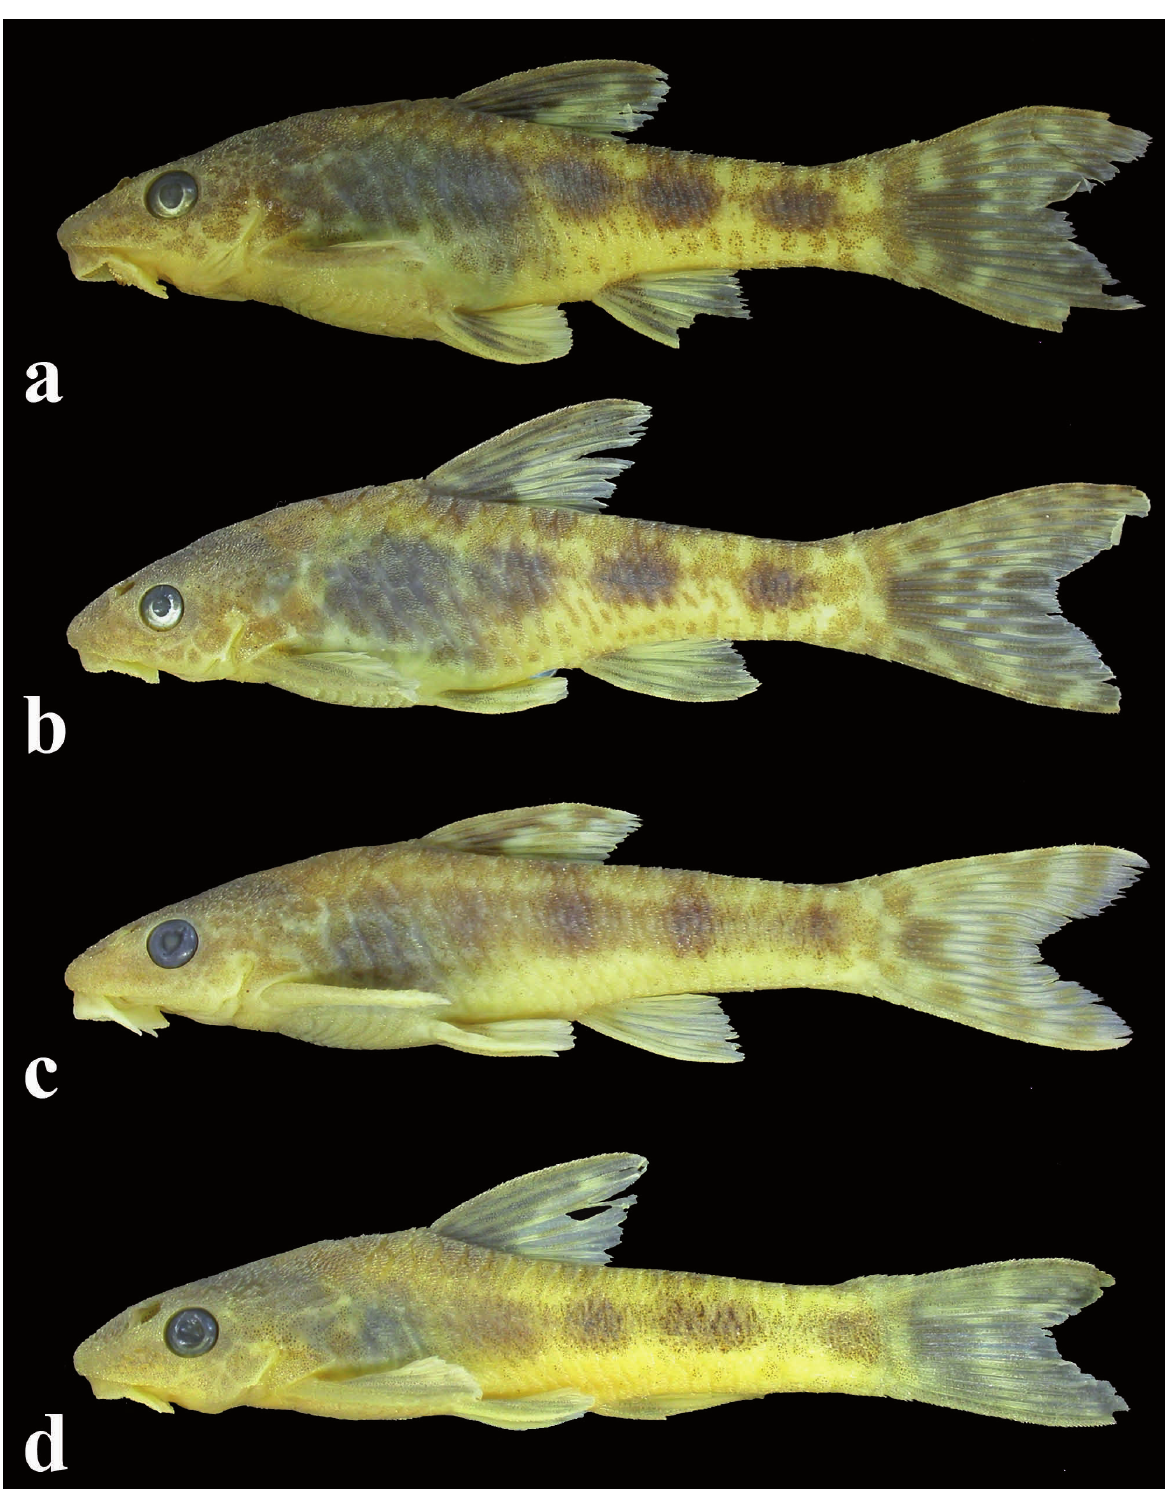
Fig. 2. Color variation of Otocinclus flexilis . (a) and (b) : MCP 17414, SL = 37.6 and 44.6 mm respectively. (c) and (d) : MCP 18307, SL = 37.2 and 36.8 mm